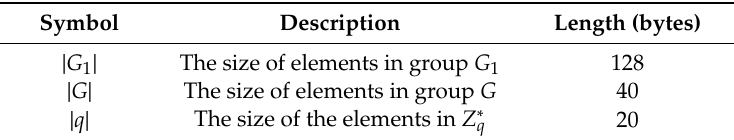
Table 4. Group parameter [11,29,37].